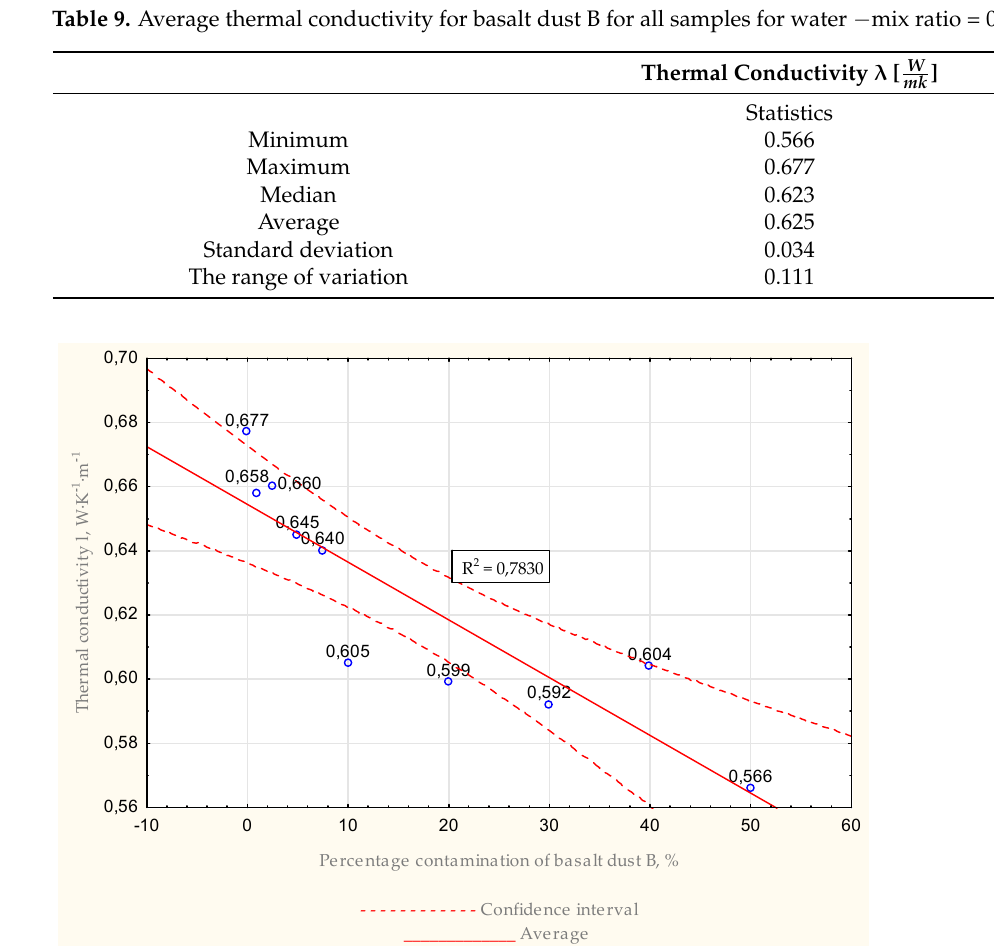
Figure 13. Average thermal conductivity for basalt dust B for water − mix ratio = 0.6.